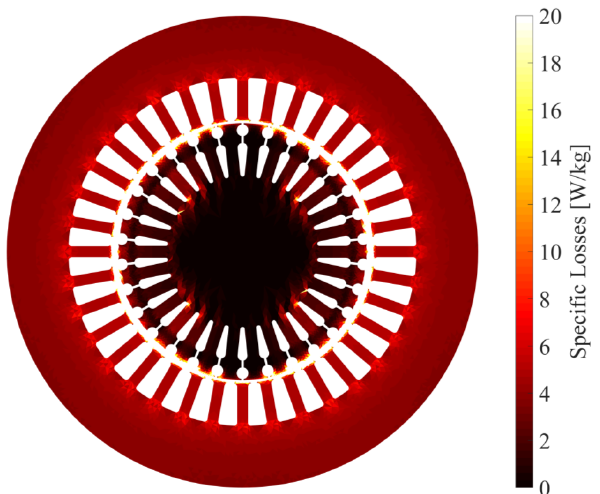
Figure 13. Distribution of the iron losses density in a squirrel cage IM; the most critical parts are the stator and rotor tooth